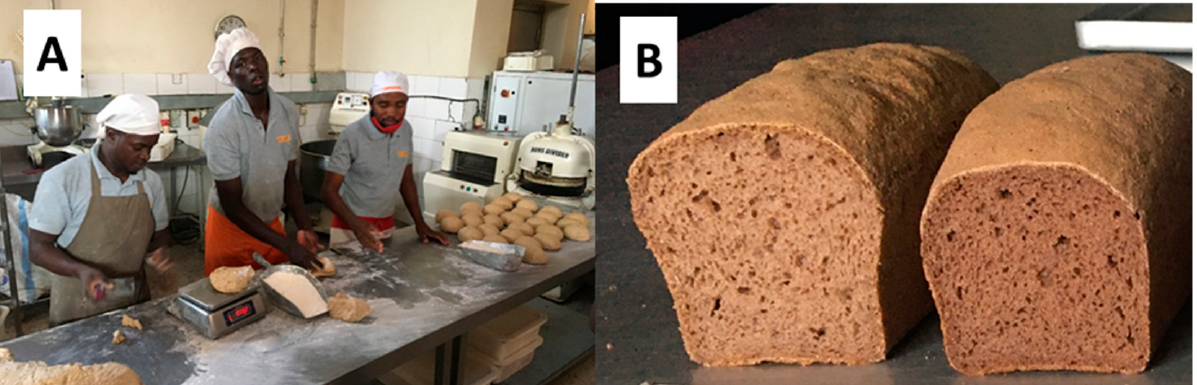
Figure 4. Preparation of a Rolex by the street vendor using the CRCs-based dough GL9 (Table 1) without yeast. After preparation and pre-baking as in Figure 3A–D, eggs are cooked on the hot plate and the chapati is added on top of the frying eggs ( A ). Once the eggs are cooked, the chapati is placed on a table and vegetables are added ( B ); the chapati is then rolled ( C ) and served to the local customers ( D ).